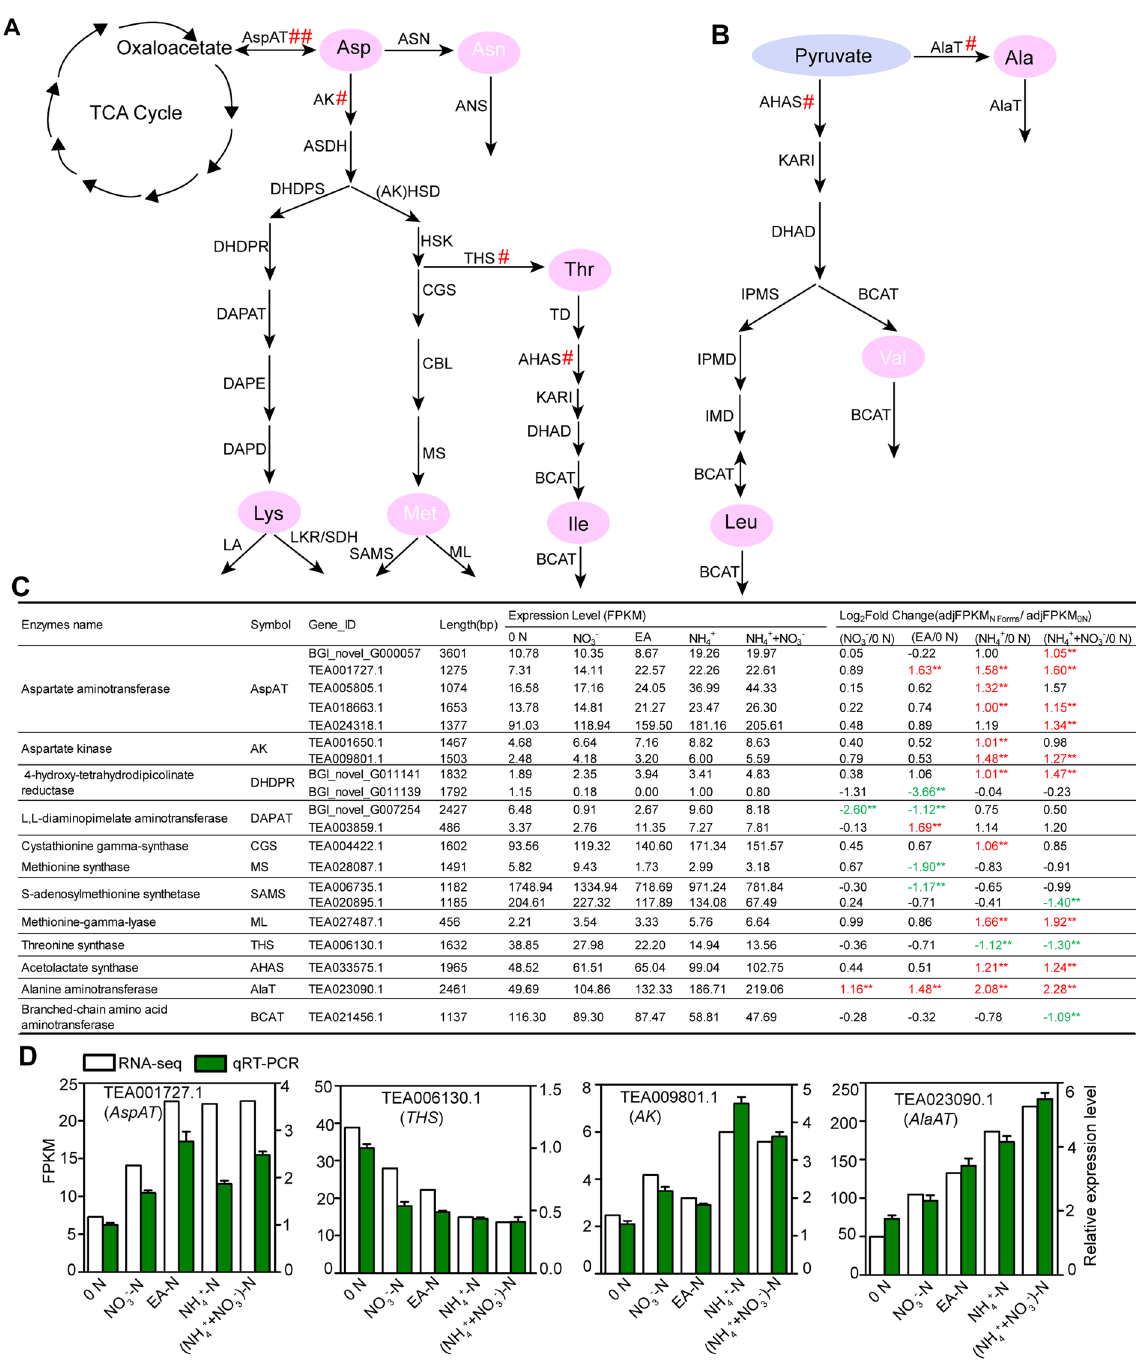
CsAK regulated the conversion under this condition. Taken together, the stable levels of Asp under the 0 N and the supply with various forms of N were probably coordinated by the expression of CsAspATs and CsAKs . Threonine synthase (THS) catalyzes Thr synthesis (Fig. 6A). CsTHS (TEA006130.1) expression was higher under 0 N and NO 3 − -N conditions (Fig. 6B). However, Thr levels under 0 N and NO 3 − -N were lower than under